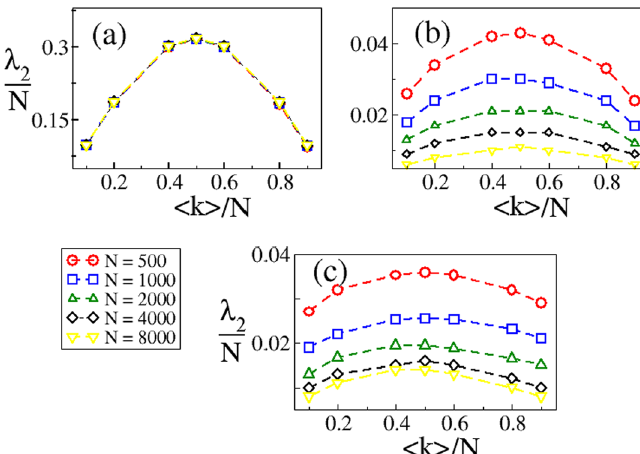
k / N for various model networks. a 1D, b ER, c (cid:31) (cid:30)